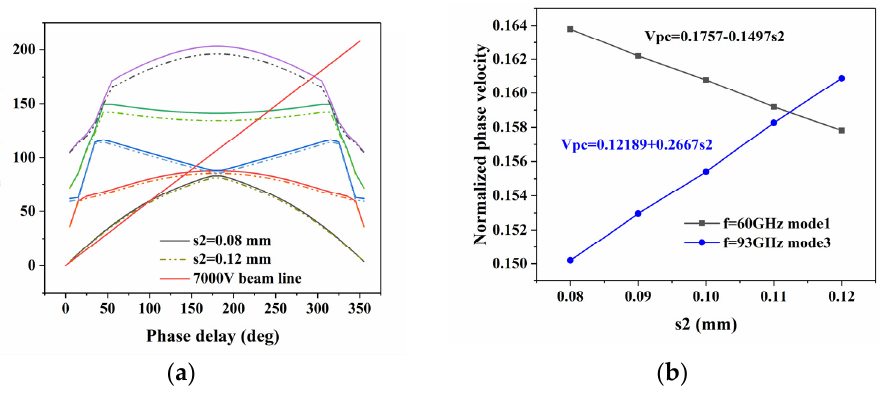
Figure 7. ( a ) ω – β diagram and ( b ) normalized phase-velocity characteristics with different s2 (in mm).